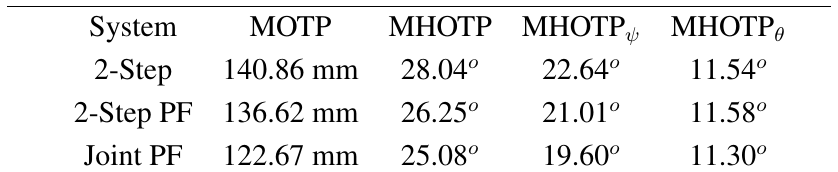
Table 2. Tracking performance joint and two-step approaches for an A-MOTA working point of